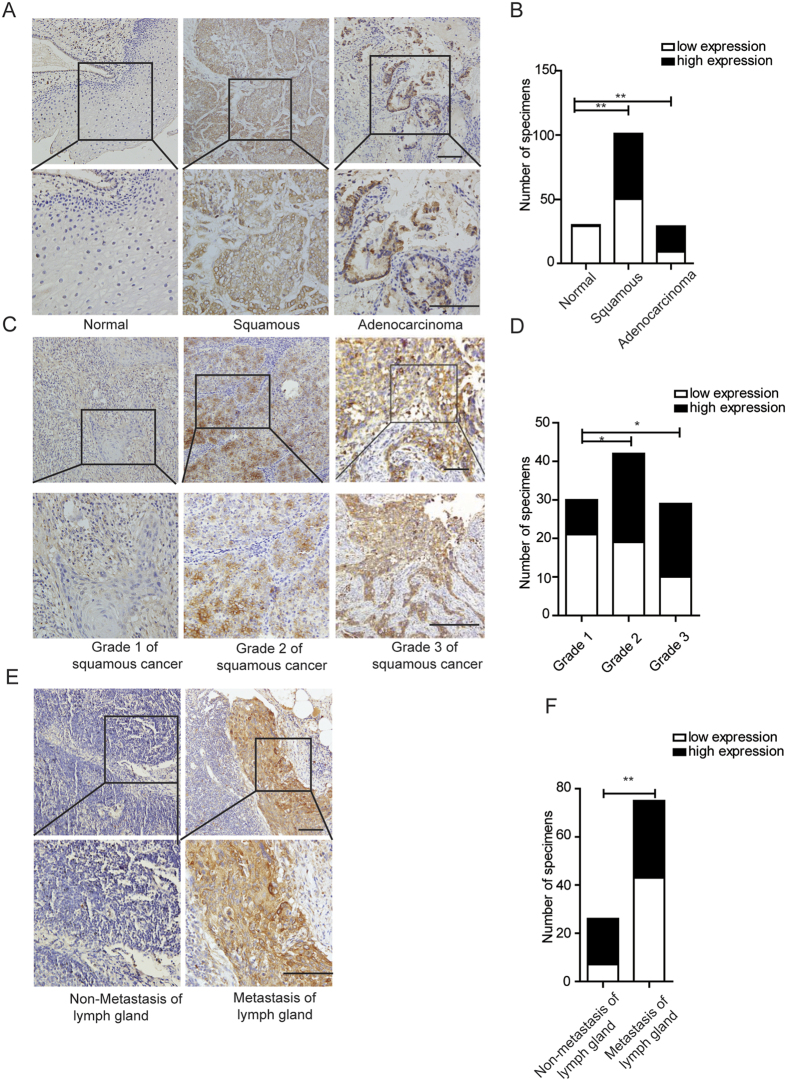
Immunohistochemical analysis of CTHRC1 in cervical cancer tissues.(A) Representative photographs of the CTHRC1 immunoreactivity in Normal, Adenocarcinoma, and Squamous cancer tissues. (B) Comparisons of CTHRC1 expression in tissues revealed by IHC analysis in Normal, Adenocarcinoma, and Squamous cancer tissues. (C) Representative photographs of the CTHRC1 staining in grade 1, 2,3 squamous cervical carcinoma tissues. (D) Comparisons of CTHRC1 expression in tissues revealed by IHC analysis grade 1, 2,3 squamous cervical carcinoma tissues. (E) Representative photographs of the CTHRC1 staining in Non-metastasis and metastasis of lymph gland tissues. (F) Comparisons of CTHRC1 expression in tissues revealed by IHC analysis Non-metastasis metastasis of lymph gland tissues. The positive staining of CTHRC1 is shown in brown color, and the cell nuclei were counterstained with hematoxylin. Scale bars, 10 μm. Original magnification: 200 × . Data are means ± SD. *P < 0.05, **P < 0.01.